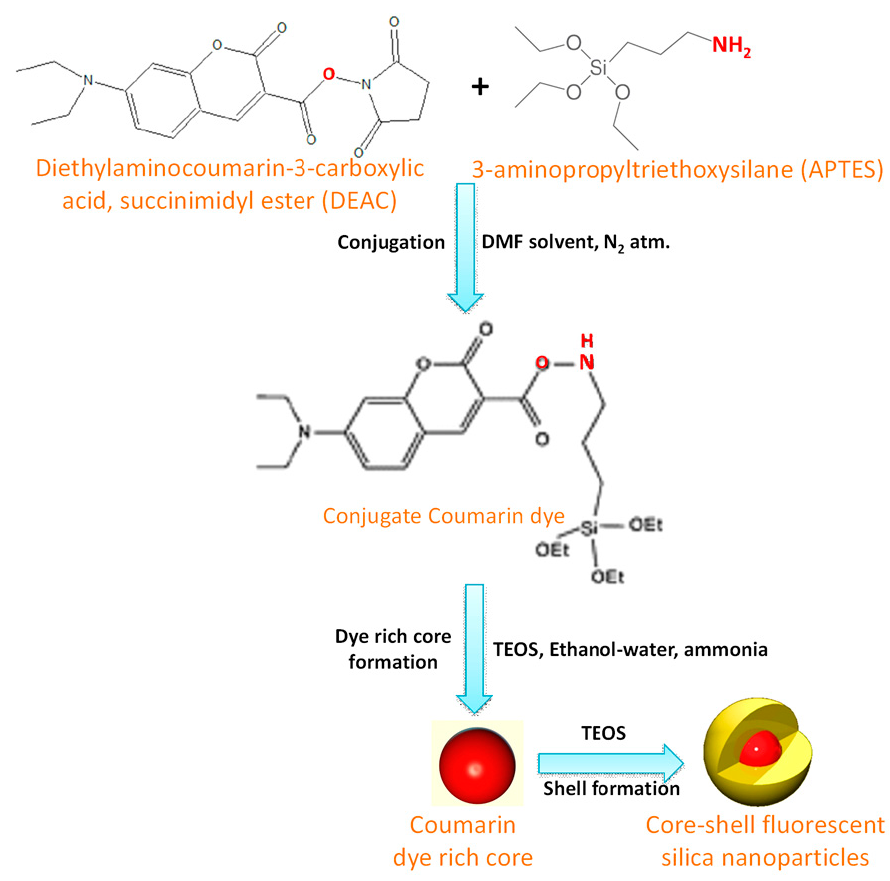
Figure 8. Formation of core-shell fluorescent silica nanoparticles using Coumarin dye rich core.